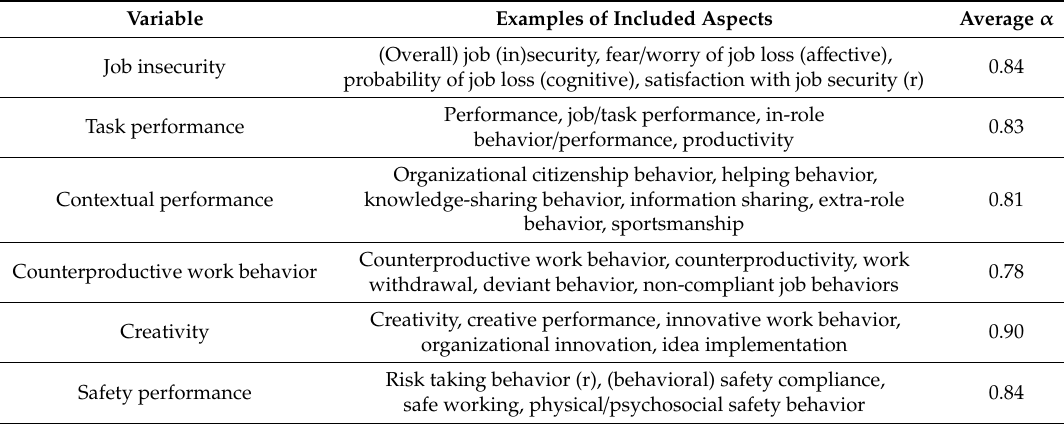
Table 1. Variables Included in the Meta-Analysis, Examples of Aspects Covered by the Primary Studies, and Average Weighted Reliability (Cronbach’s alpha) across